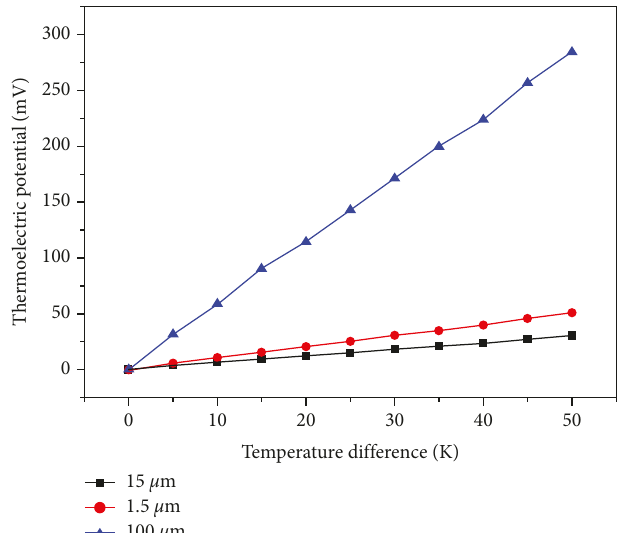
Figure 5: Relationship between the temperature difference and thermoelectric potential of the compacted Cu particle sizes. Table 3: Seebeck coefficient and electrical conductivity of the compacted Cu Particle size Seebeck coefficient ( μ